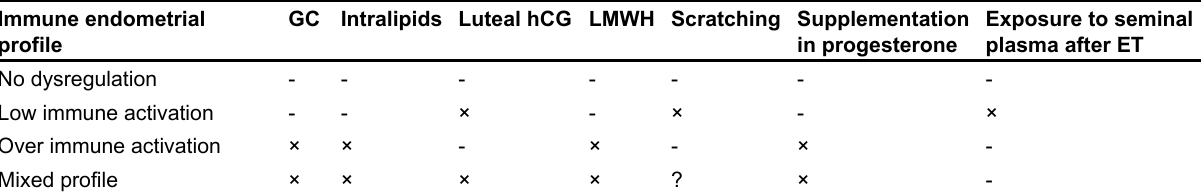
Table 1. Summary of suggested therapies according to the endometrial immune profile Immune endometrial GC Intralipids Luteal hCG LMWH Scratching Supplementation Exposure to seminal profile in progesterone plasma after ET No dysregulation - - - - - - - Low immune activation - - × - × - × Over immune activation × × - × - × - Mixed profile × × × × ? ×